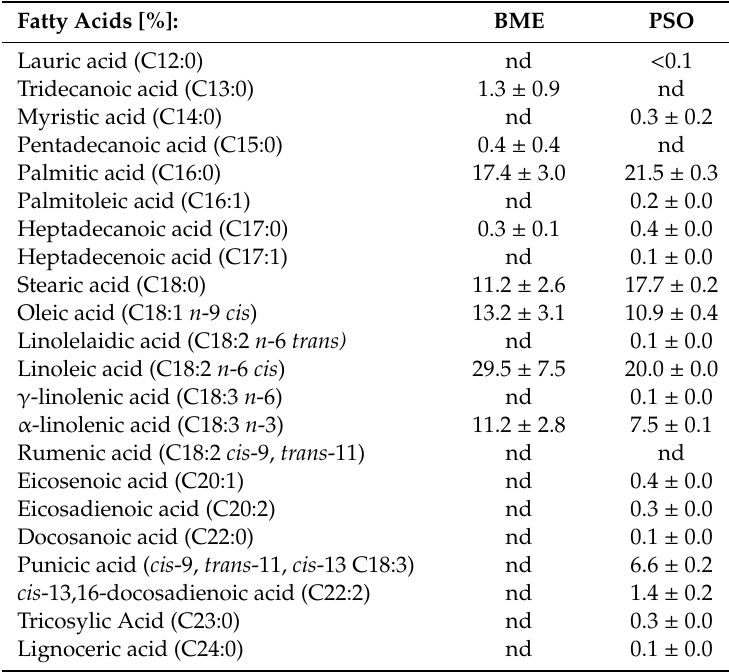
Table 1. Fatty acids profile [%] of BME and PSO.